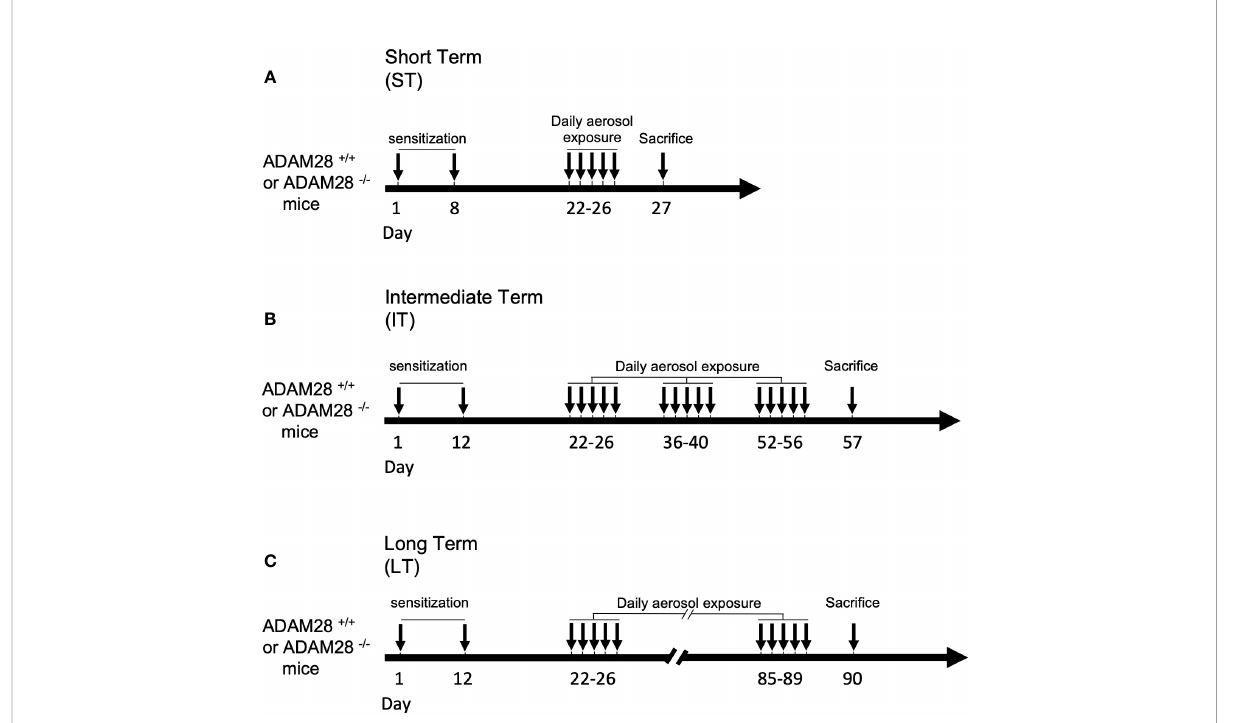
FIGURE 1 Experimental procedure. Short-term (ST) protocol (A) , intermediate-term (IT) protocol (B) , and long-term (LT) protocol (C) . PBS/ovalbumin (OVA) sensitization and exposure protocols. Mice were sensitized on days 1 and 8 by intraperitoneal injection of 10 m g of OVA. Mice were subsequently exposed to daily PBS aerosol or OVA 1% aerosol for 30 min for ST, IT, or LT duration (see materials and methods section for the detailed